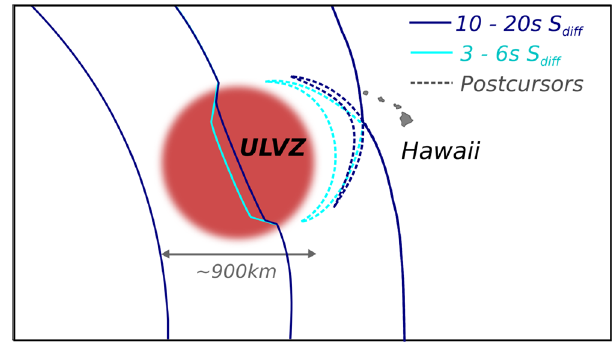
Fig. 2 Illustration of wavefront refraction for the long-period (black) and short-period (green) Sdiff postcursors. Sketch shows the wavefront propagating through a 900 km diameter cylindrical ultra-low velocity zone (ULVZ) (red) and caused delayed long-period (blue) and short-period (cyan) S diff